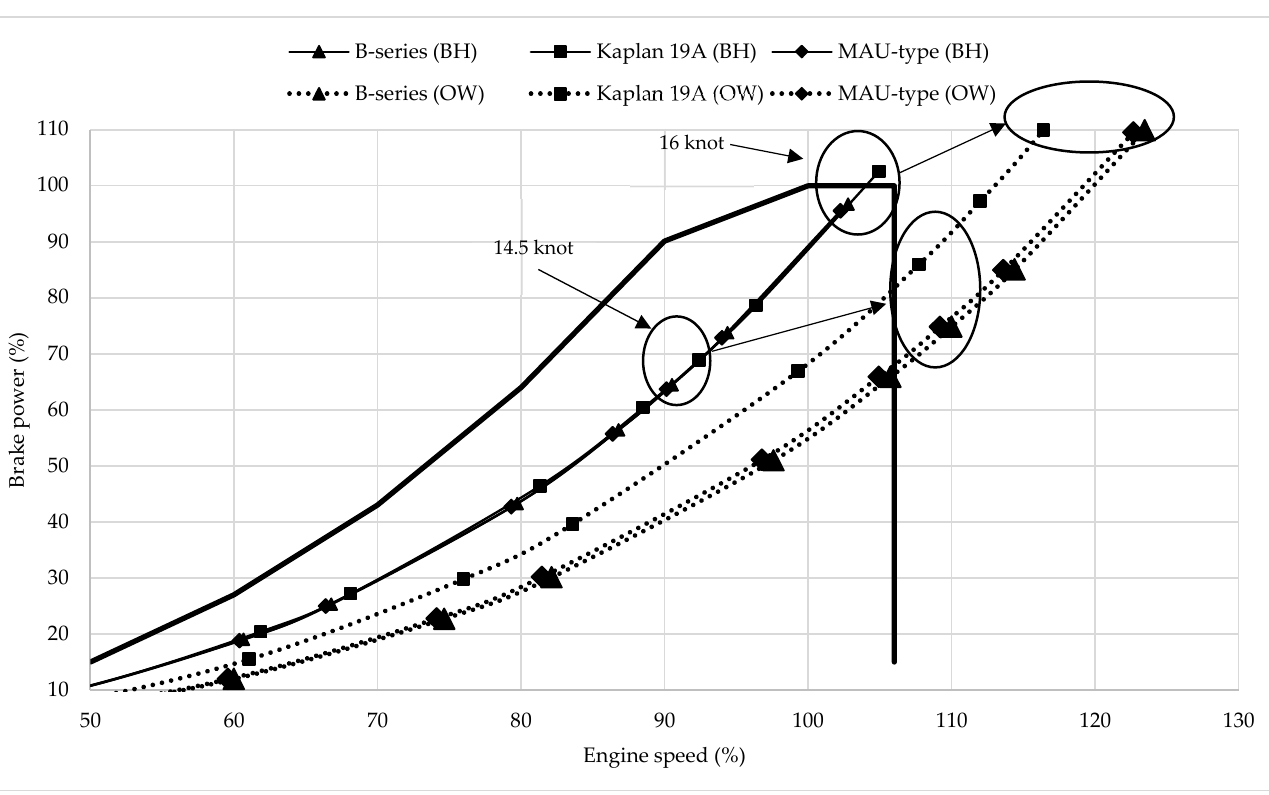
Figure 5. Propeller operating points in engine load diagram in both behind ‐ hull and open ‐ water conditions.